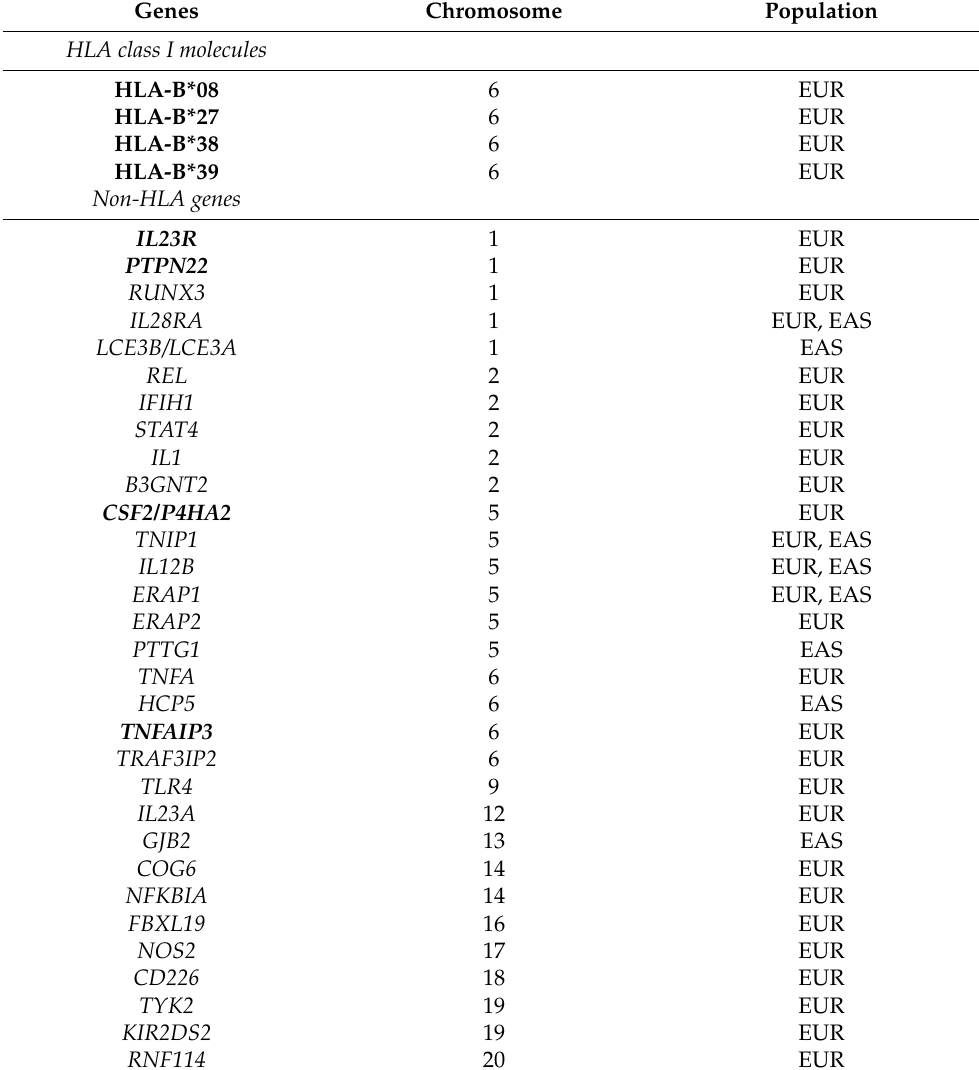
Table 1. Genome-wide significant genetic variations associated with psoriatic